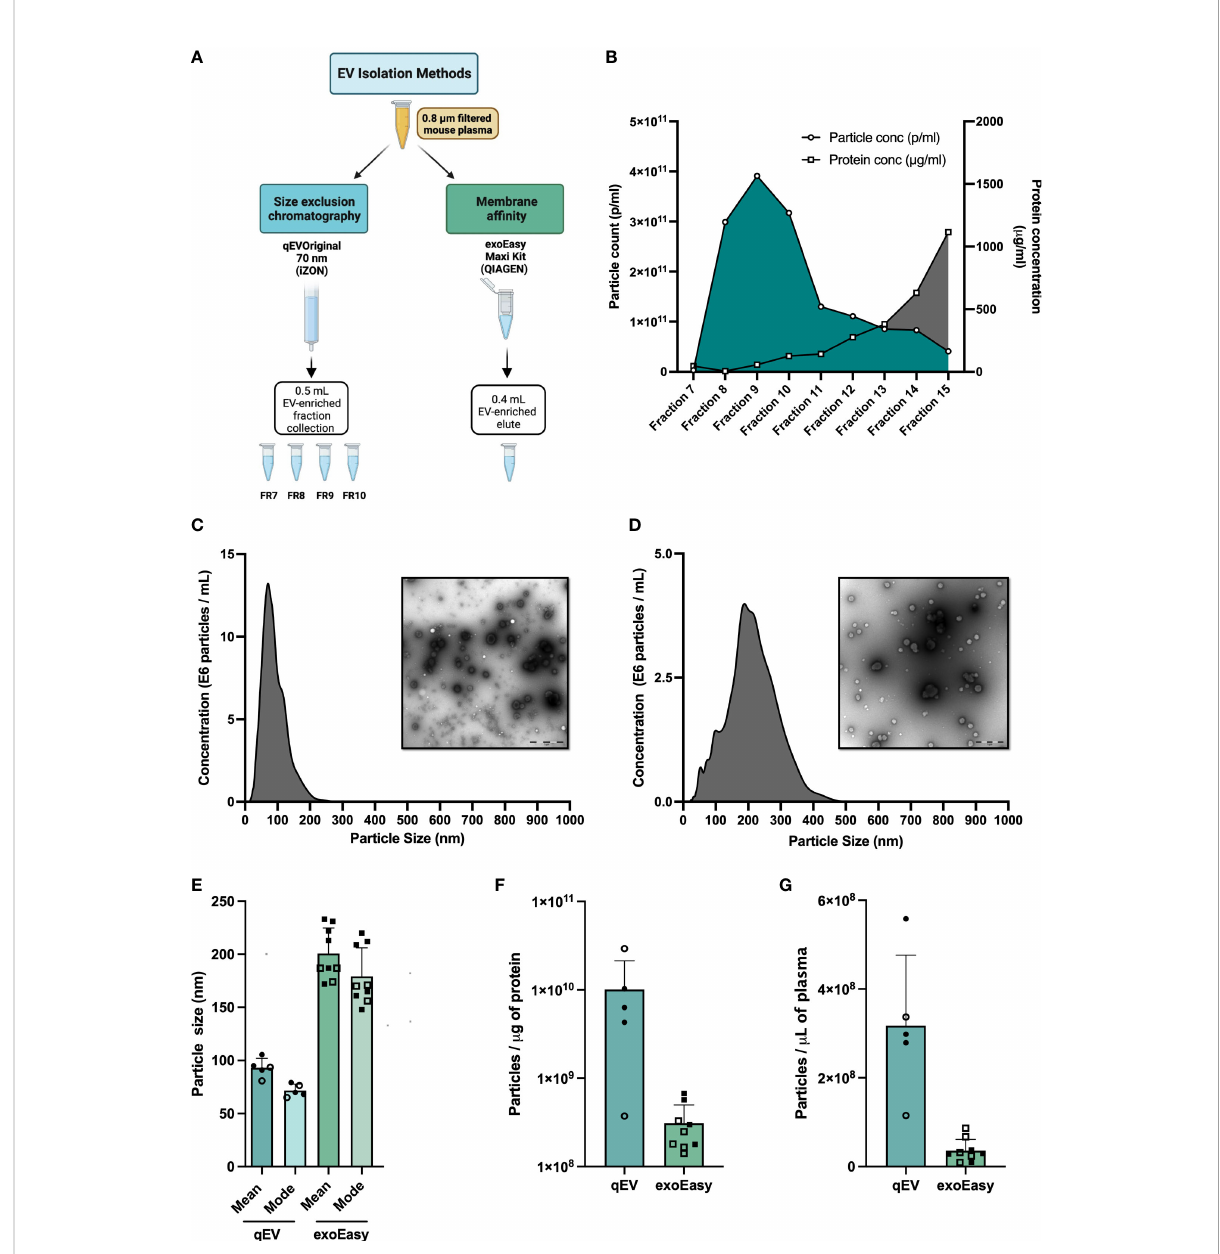
FIGURE 1 Extracellular vesicle (EV) enrichment and characterization. (A) Plasma collection work fl ow. Blood samples from pre-diabetic NOD mice were collected in EDTA tubes. Plasma was isolated and fi ltered through a 0.8 m M fi lter prior to EV enrichment. EVs were enriched using one of two isolation methods, Size Exclusion Chromatography (SEC) using the qEVoriginal 70 nm column (iZon), or Membrane af fi nity (MA) using exoEasy Maxi spin columns (Qiagen). (B) Fresh plasma samples (560 or 900 m L) were applied to qEV original 70 nm columns. Fractions 7 to 15 were collected and particle count and protein content in each fraction were analysed by nanoparticle tracking analysis (NTA) and BCA assay, respectively. Shown is a representative graph made from the analysis of 900 m L of plasma. (C, D) Size distribution (nm) of particles (690 m L fresh plasma for each experiment) enriched by qEVoriginal 70 nm column, pooled fractions 7-10 (C) or exoEasy spin column (D) with representative TEM pictures. Scale bar size 1 m M. (E – G) Plasma was collected from non-diabetic NOD mice and was enriched for EVs using qEV (pooled fractions 7-10) or exoEasy. (E) Average mean and modal size of the enriched particles as determined by NTA (NanoSight NS500). (F) Average particle number per microliter of mouse plasma used to isolate EVs by qEV or exoEasy. (G) Ratio of the average of particle number (measured by NanoSight NS500) and protein amount (Pierce BCA Protein Assay kit, Thermo Fisher Scienti fi c, USA) for qEV or exoEasy enriched EVs. Bars represent mean and standard deviation of a total of 9 and 5 independent enrichments using qEV and exoEasy, respectively. (Open circles and squares correspond to EV samples enriched using frozen plasma samples (qEV, n = 2, exoEasy, n = 5); closed circles and squares correspond to EV samples isolated from fresh plasma samples (qEV, n = 3; exoEasy, n =